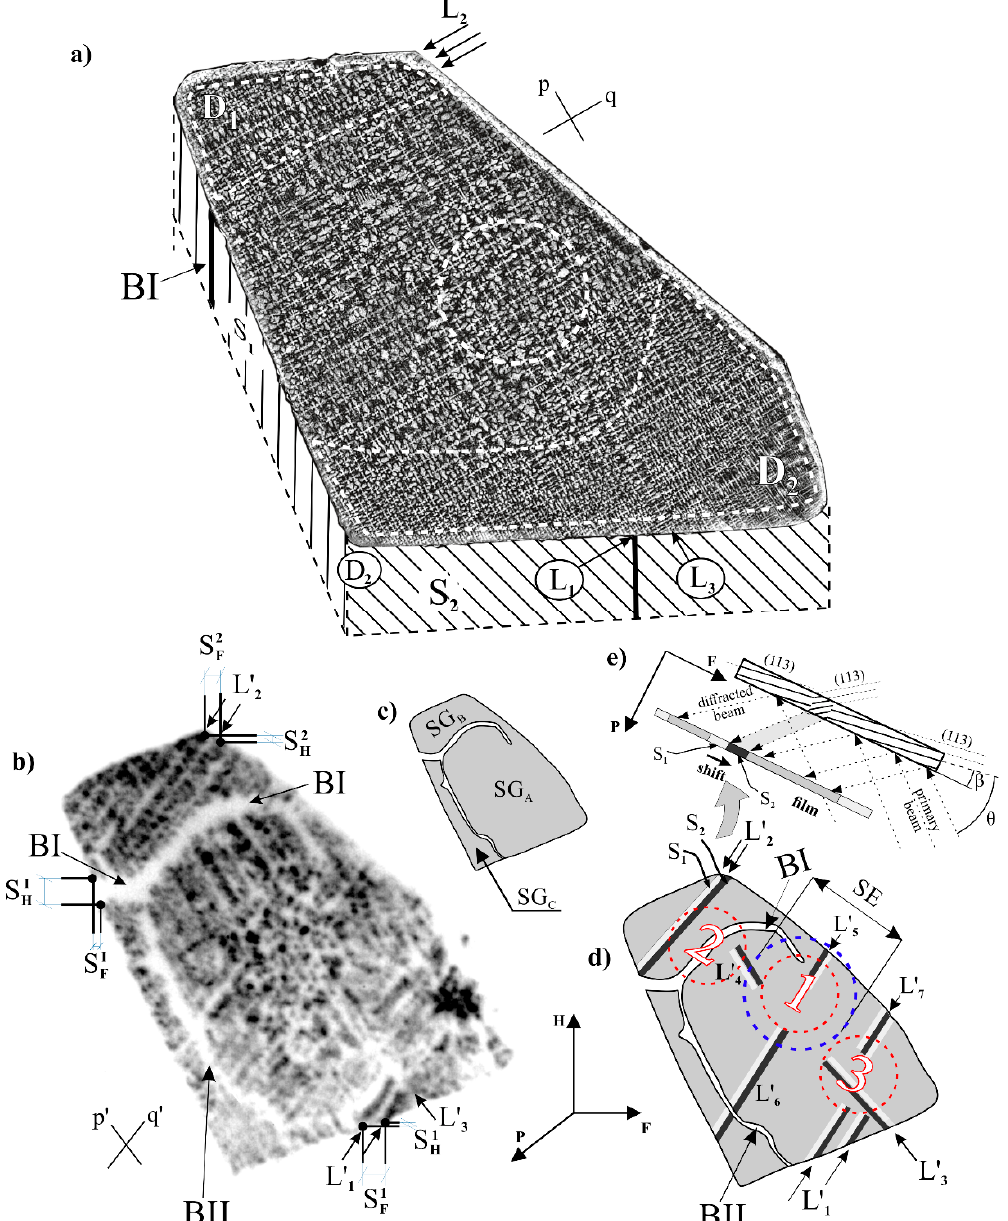
Figure 2. ( a ) Example of a macro-SEM image obtained from the P A –P A surface; p and q —the directions of dendritic arms; ( b ) example of the topogram obtained from the P A –P A surface; BI, BII—the contrast bands visualize the macroscopic low-angle boundaries LAB-I and LAB-II; p ′ and q ′ —the directions of the contrast bands in the topogram; axis H and F lie in the plane of the microsection and the P axis is perpendicular to them; ( c ) scheme of sub-grains SG A , SG B , and SG C visualized in the topogram; ( d ) scheme of the topogram with marked areas 1, 2, and 3 for PALS measurements; SE—selector extension area of root; ( e ) scheme of the contrast bands formation in the topogram.